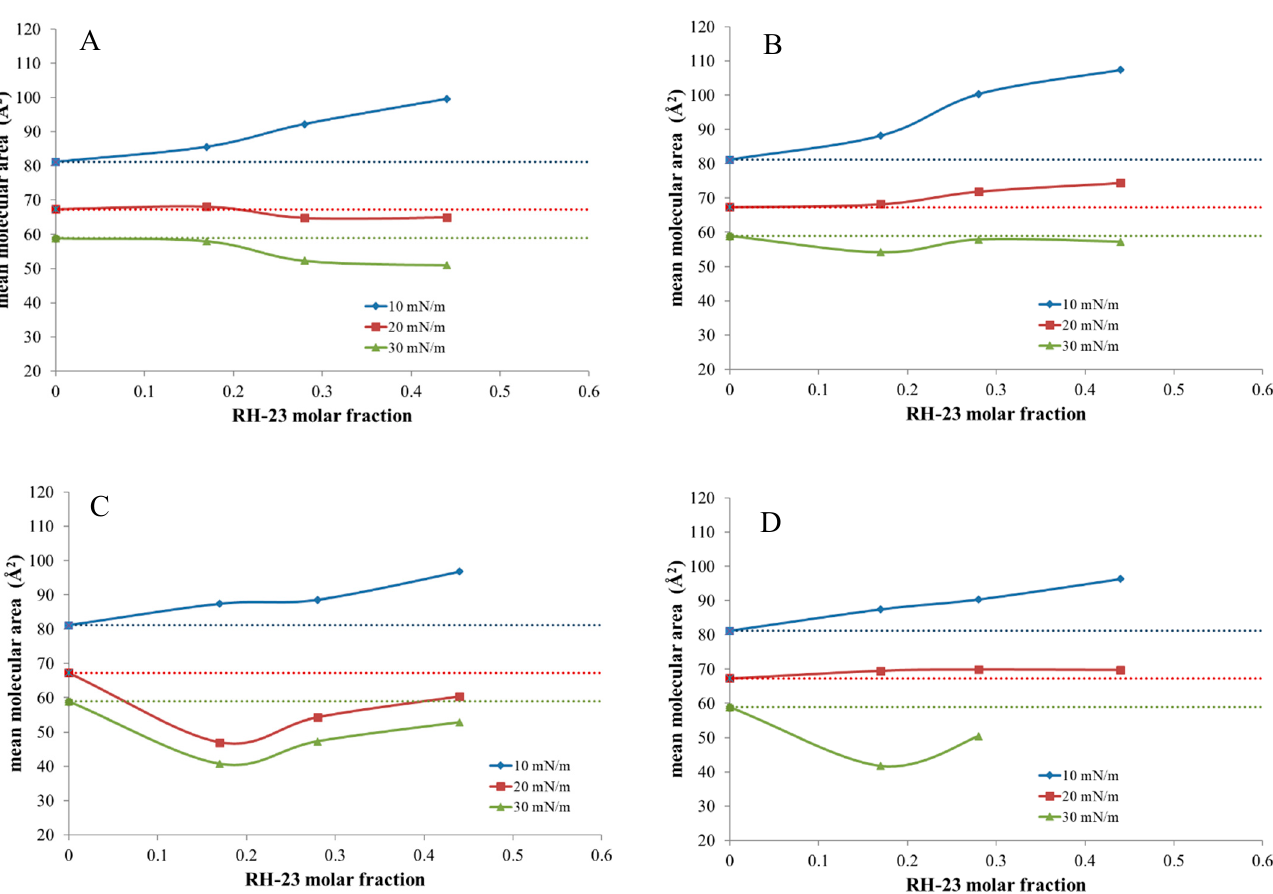
Figure 8. Average area per molecule (Å 2 ) of DMPC monolayers with RH-23 at increasing molar fractions in the subphase, as a function of the RH-23 molar fraction, at 10, 20, and 30 mN/m surface pressure. (A) is without pause, (B) is with the pause at 10 mN/m, (C) is with the pause at 20 mN/m and (D) is with the pause at 30 mN/m.